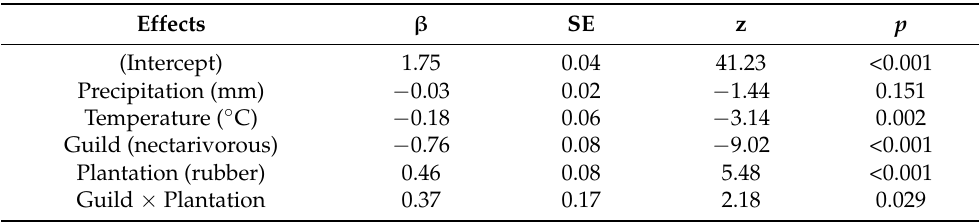
Table 2. Results of the best generalised linear models (model 3) for bat abundance to seasonal changes in climate (temperature, humidity, and precipitation), plantation types, and guild. Relationships are visualised in Figure